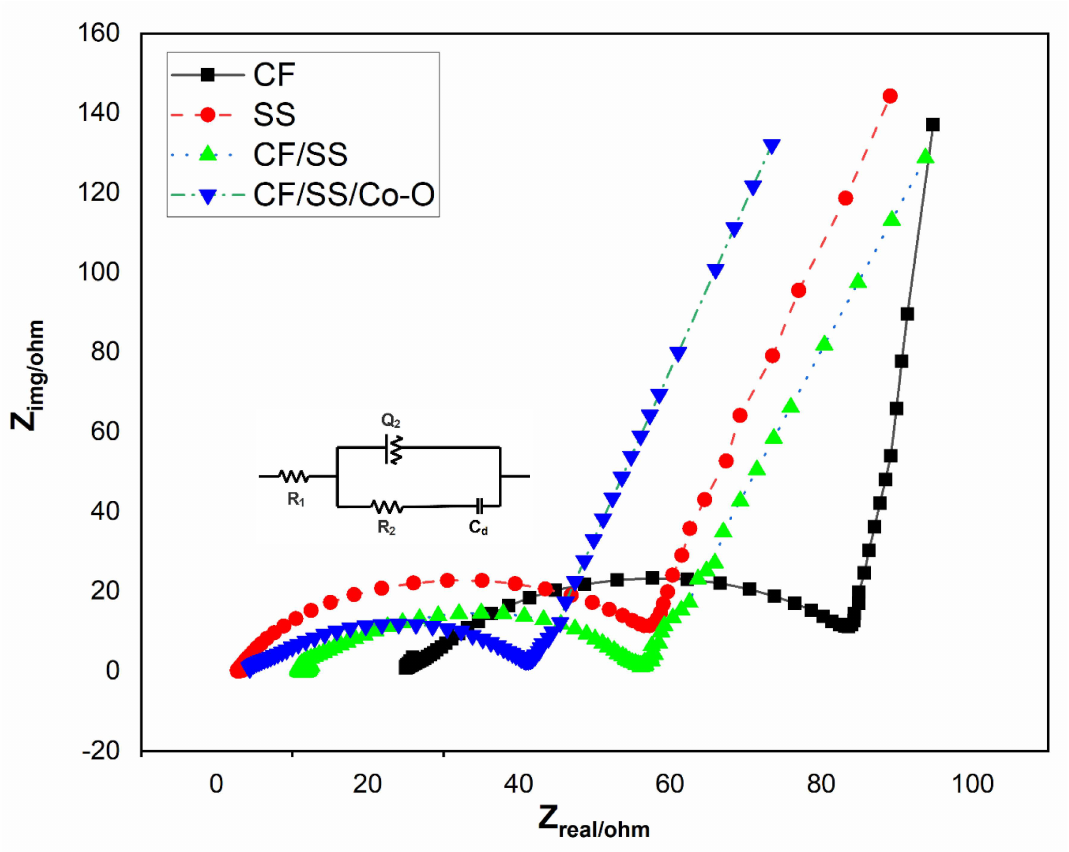
Figure 8. Nyquist plot for MES for all the varied electrode materials. (Rohm: ohmic resistance, R ct : charge transfer resistance, Q 2 : constant phase angle element, and C d : interfacial